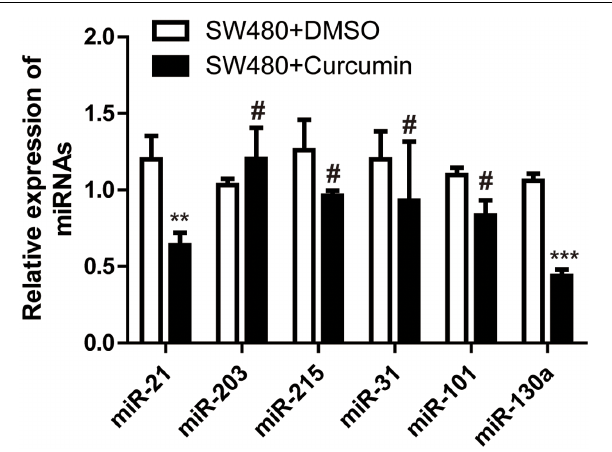
FIGURE 4 | Curcumin regulated several miRNAs in SW480 cells. Q-PCR showing the expression level of miRNAs as indicated. Data were represented as mean ± SD; n = 3 independent experiments. ∗∗ p < 0.01, ∗∗∗ p < 0.001, # p > 0.05.